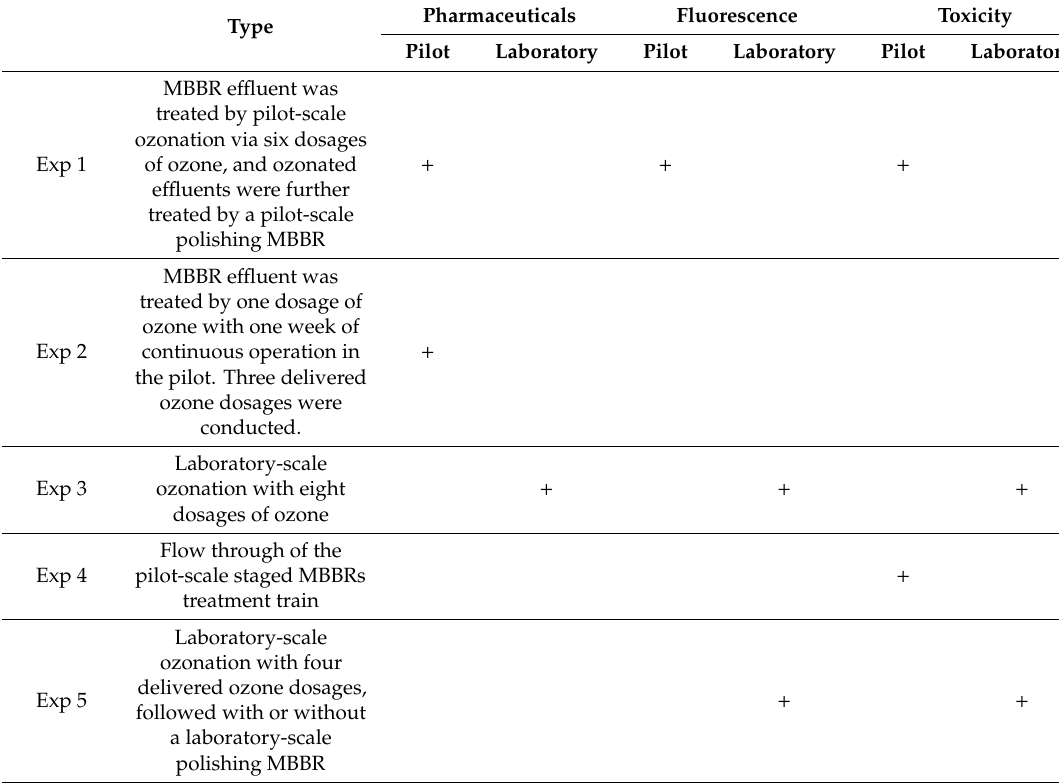
Table 2. Outline of experiments at the pilot and laboratory